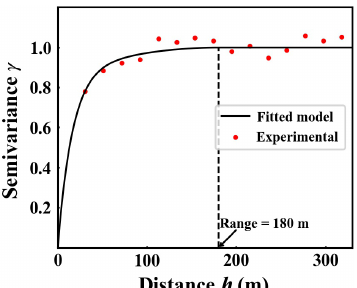
Figure 4. Experimental semivariances based on (cid:15) ∗ and fitted parameterized semivariogram model given by Eq. (9). The range of the semivariogram model is 180m. It indicates the maxi- mum autocorrelation length of DEM error, on which the size of the spatial moving filter d depends (see Sect.